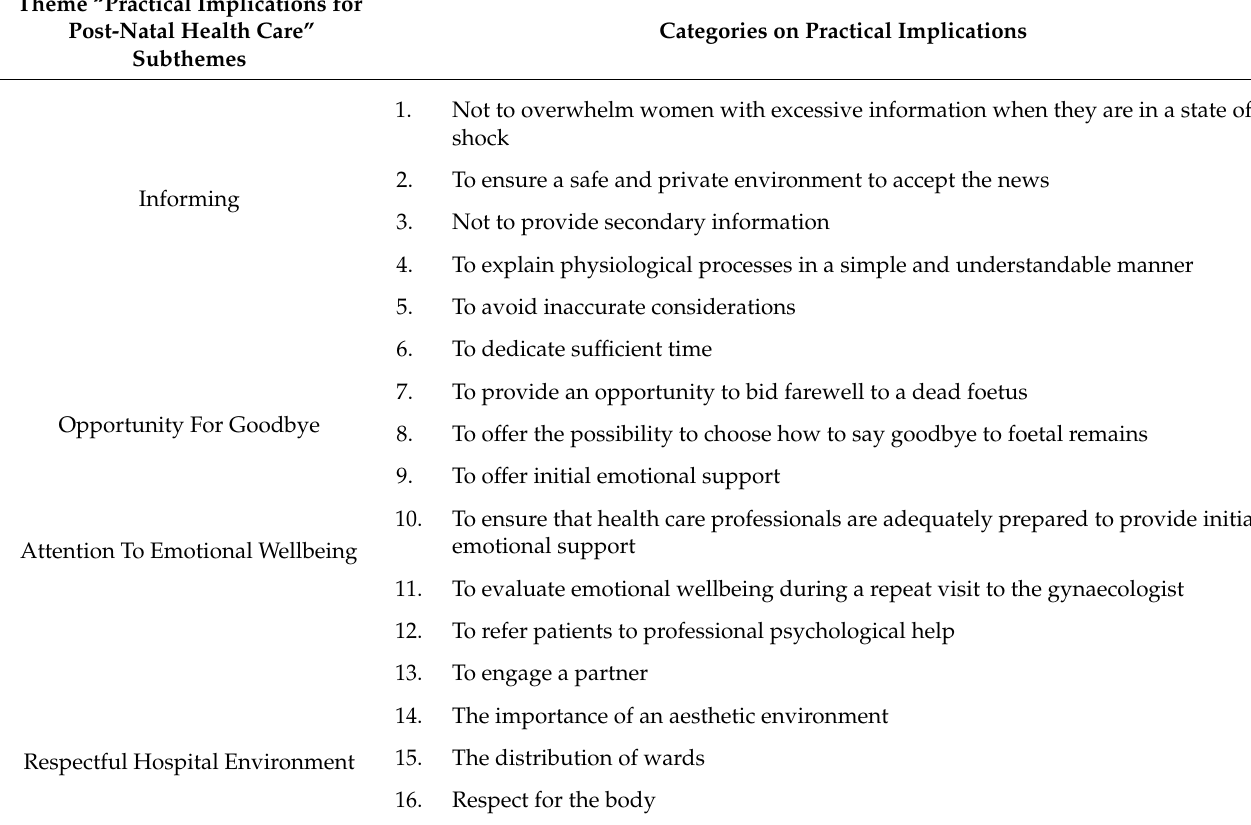
Table 2. Practical implications for post-natal health